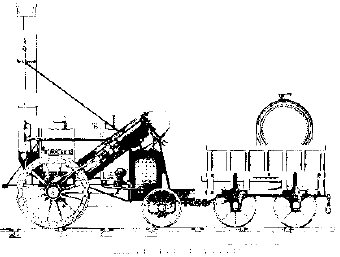
Figure 11. GeorgeStephenson’s “Rocket”, 1829, the first practical locomotive